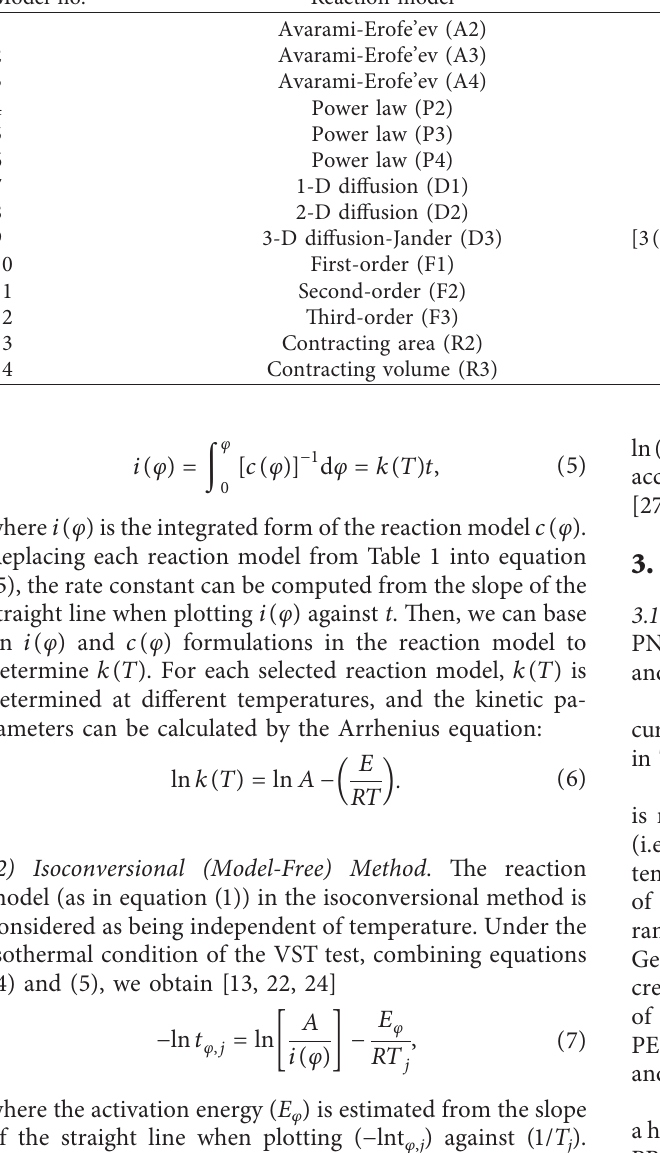
Table 2: Different reaction models generally applied to describe the thermal decomposition in solids [21, 22, 24, 25]. Model